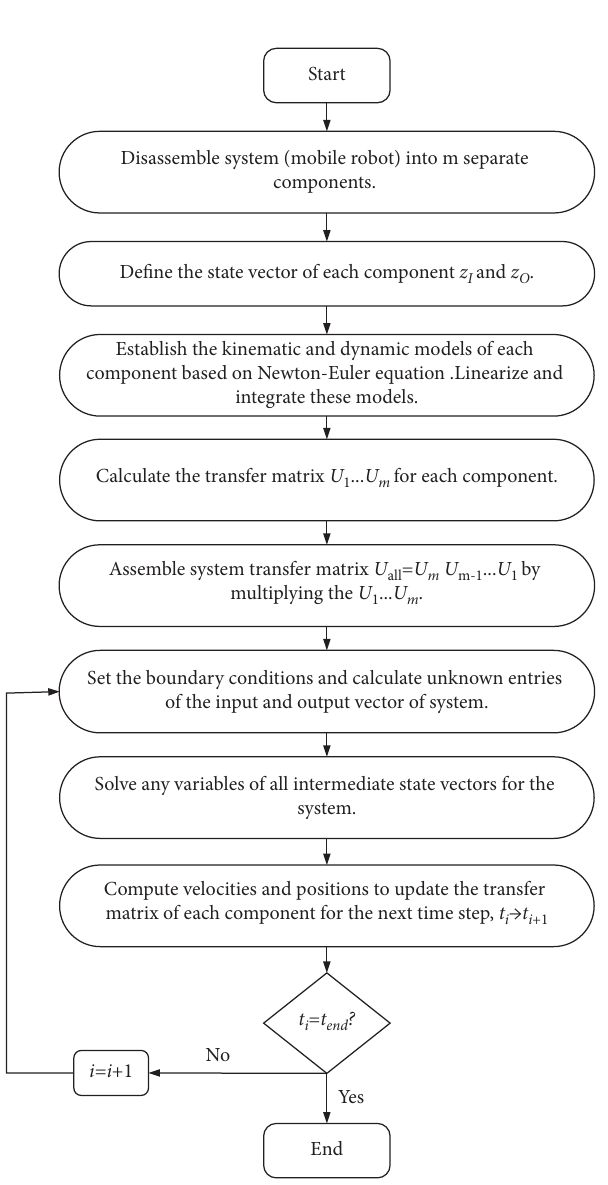
Figure 2: Modeling procedure of MS-DT-TMM.